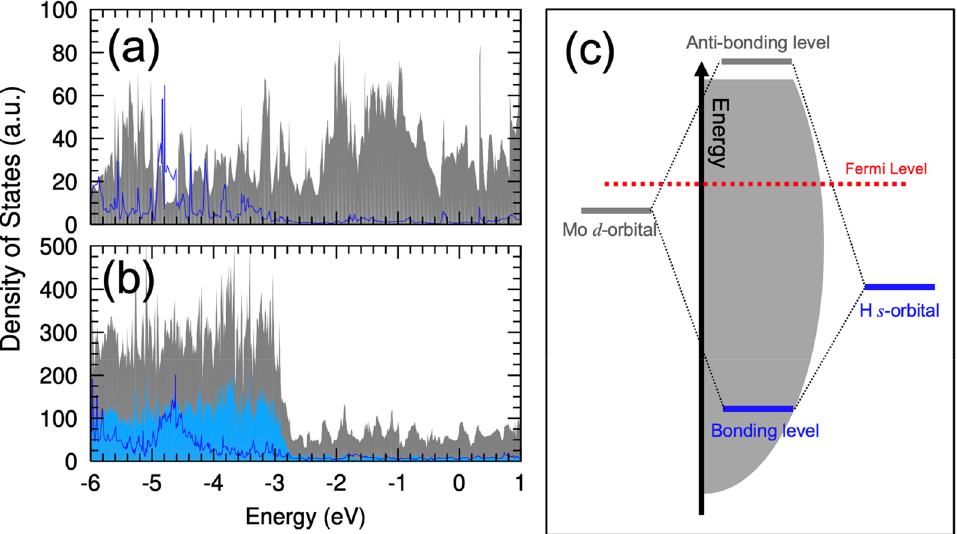
Figure 5. Electronic structure of the H absorbed Mo 2 C. Density of states of ( a ) the H absorbed Mo 2 C and ( b ) the H absorbed Mo 2 C on the Ag substrate. Shaded gray is the total density of state and blue line is the projected density of state onto the absorbed H atom, which is rescaled by multiplying by factors of 50 in ( a ) and 250 in ( b ). Fermi level is set to zero. In ( b ), shaded sky blue is the projected density of state onto the Ag substrate. ( c ) Schematics of the formation of the H bonding level. The filled gray represents the Mo d -bands and Fermi level is denoted by the red dotted line. The level interaction between the Mo d -orbital and H s -orbital form the bonding level around -5 eV in ( a ), which is dispersive also by interaction with other